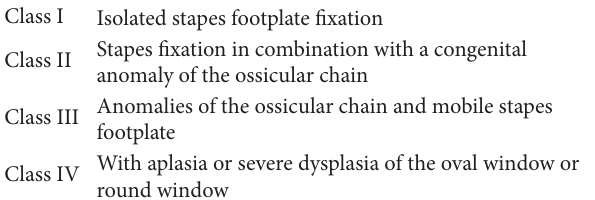
Table 1: Classification of congenital ossicular malformations (adapted from Teunissen and Cremers [10]).